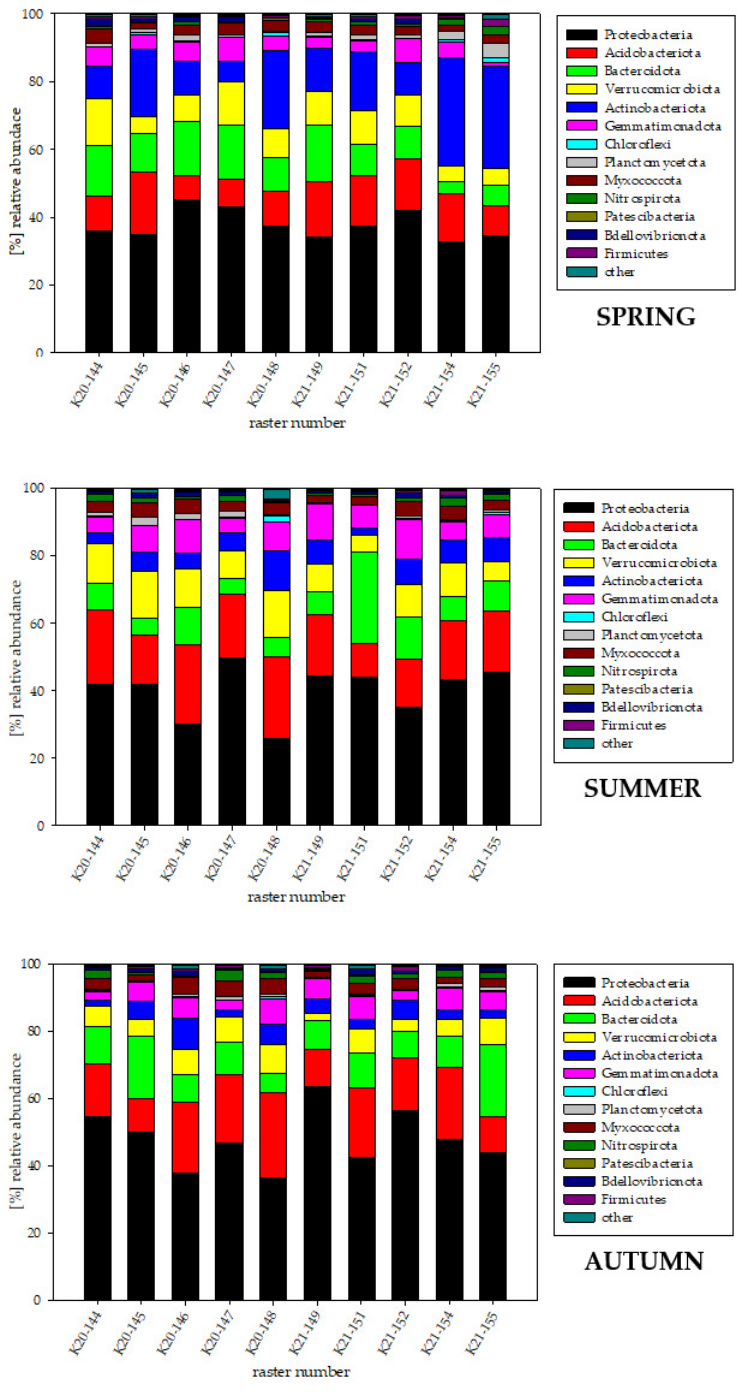
Figure 4. Bacterial phyla in the rasters of field K20 under the intercropping mixture and field K21 under the maize monoculture in spring, summer, and autumn. Proteobacteria were the dominants (34.88–45.17% for K20 and 32.82–41.83% for K21 in spring; 36.45–54.51% for K20 and 42.32–63.76% for K21 in summer; 25.97–49.69% for